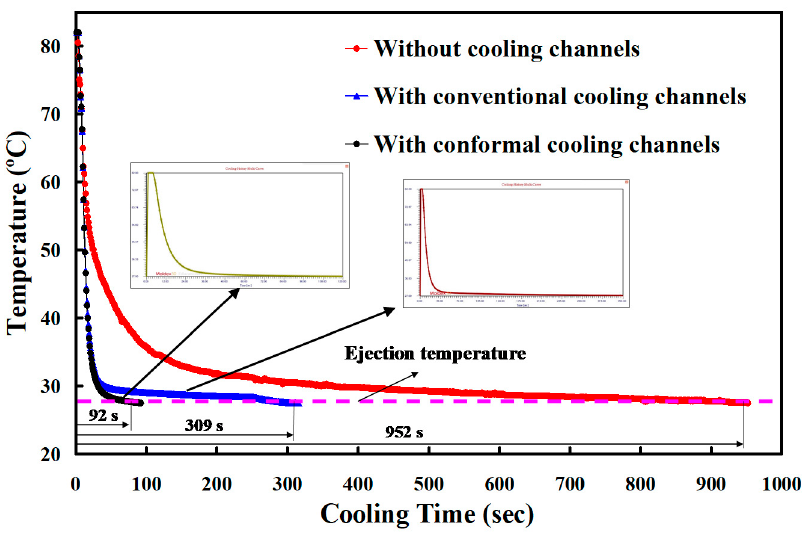
Figure 11. Cooling time for three injection molds.